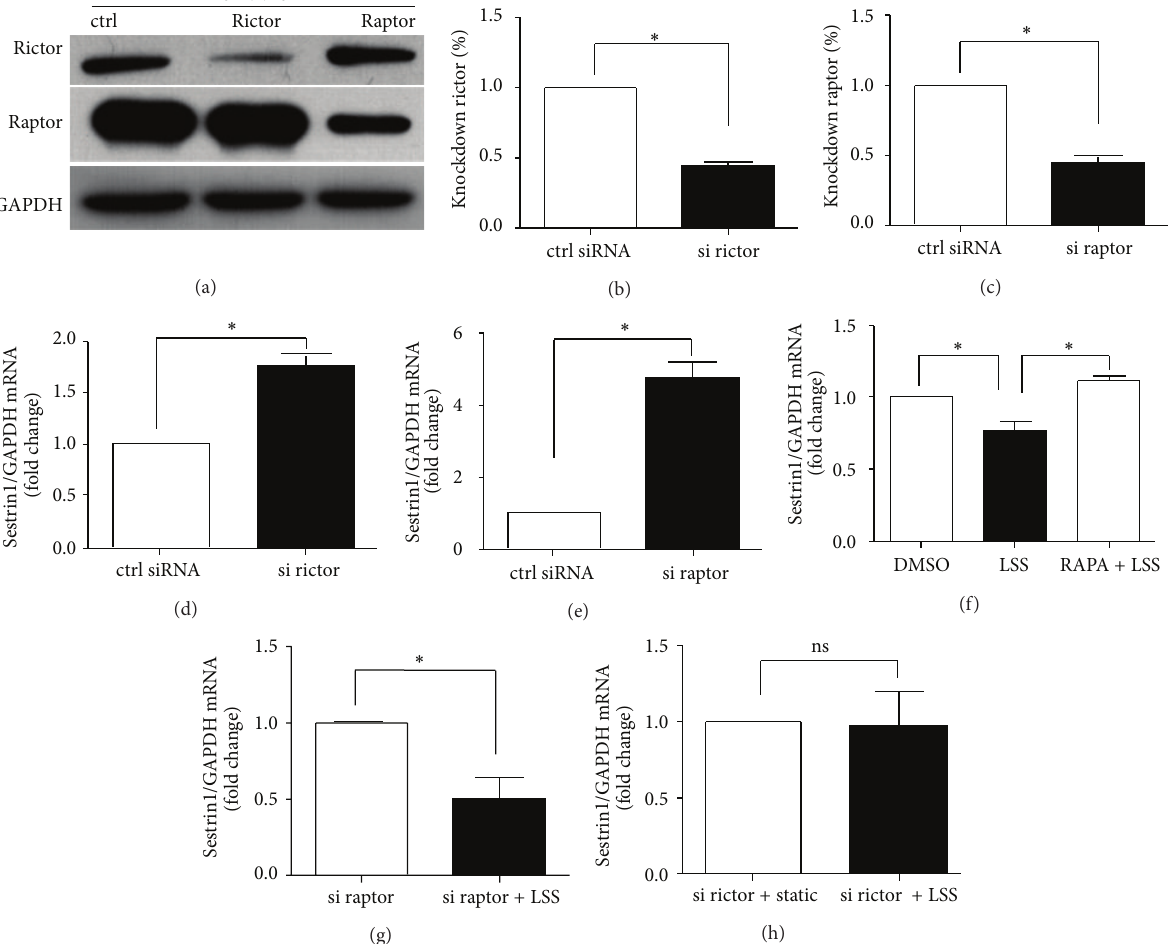
Figure 5: Upregulation of sestrin1 expression by rapamycin protected ECs from LSS insults via mTORC2 inhibition. (a) HUVECs were treated with siRNA against rictor, raptor, or scrambled control siRNA (ctrl siRNA). 48 h after transfection, cells were harvested for the detection of Rictor, Raptor, and GAPDH protein levels by western blot. ((b)-(c)) Percentage of knockdown rictor or raptor was analyzed relative to GAPDH, ∗ 𝑃 < 0.05 ; 𝑛 = 3 . ((d)-(e)) 48 h after transfection, sestrin1 expression was significantly elevated in rictor siRNA or raptor siRNA group, ∗ 𝑃 < 0.05 ; 𝑛 = 4 . (f) Rapamycin (RAPA) reduced LSS induced sestrin1 decreasing, ∗ 𝑃 < 0.05 , 𝑛 = 4 . (g) After mTORC1 inhibition with raptor siRNA transfection for 48 h, HUVECs were exposed to LSS or kept static. Expression of sestrin1 determined by real time PCR was reduced after LSS exposure, ∗ 𝑃 < 0.05 , 𝑛 = 4 . (h) After inhibition of mTORC2 with rictor siRNA, sestrin1 expression was not decreased by LSS in HUVECs as compared with static group, 𝑃 = 0.7731 , 𝑛 = 4